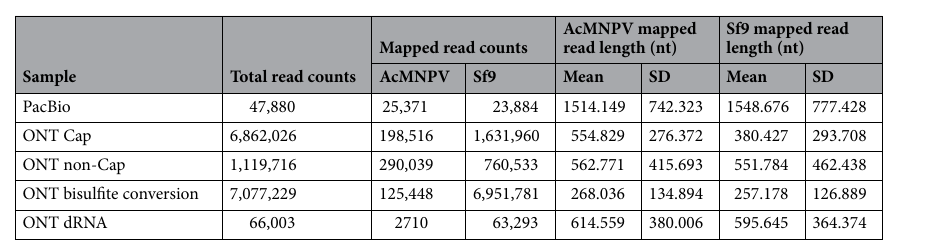
Table 1. Read counts and read lengths of the samples used in this